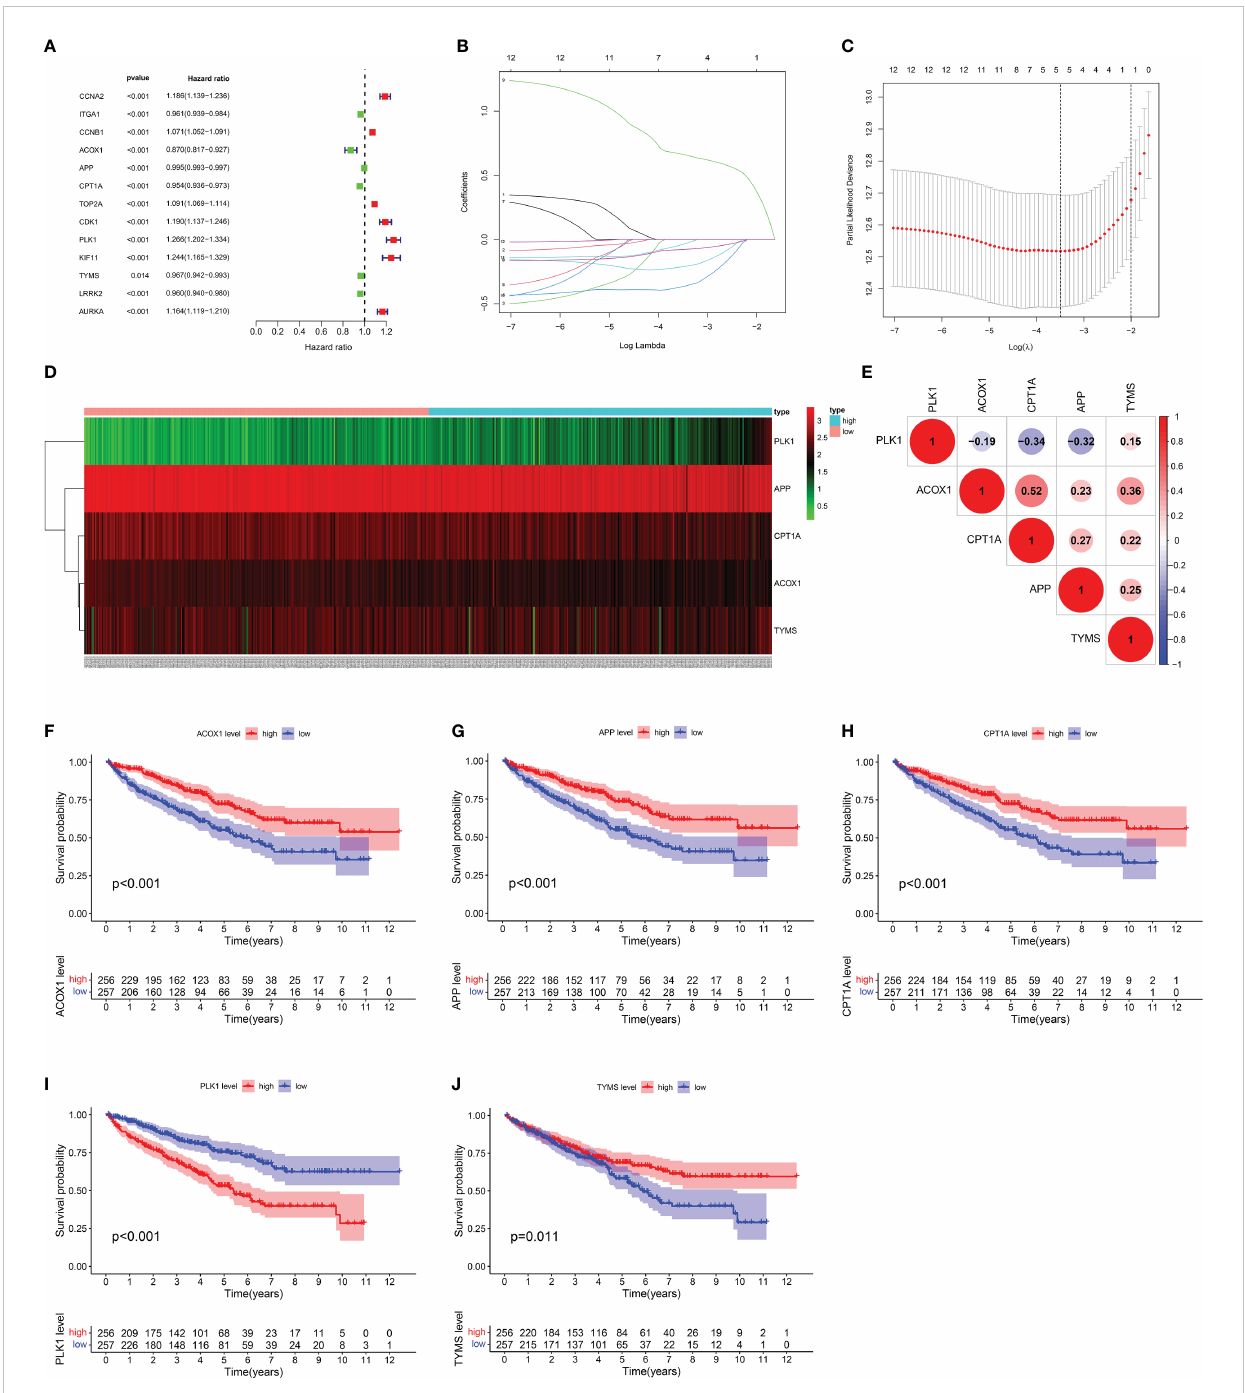
FIGURE 5 Assessment of target gene signatures for KIRC patients. (A) The forest plot of univariate Cox proportional analysis. (B, C) The LASSO Cox regression analysis for detecting the representative gene. (D) Heatmap of target gene signatures. (E) The correlation analysis between target gene signatures. (F – J) Kaplan-Meier survival analysis of target gene